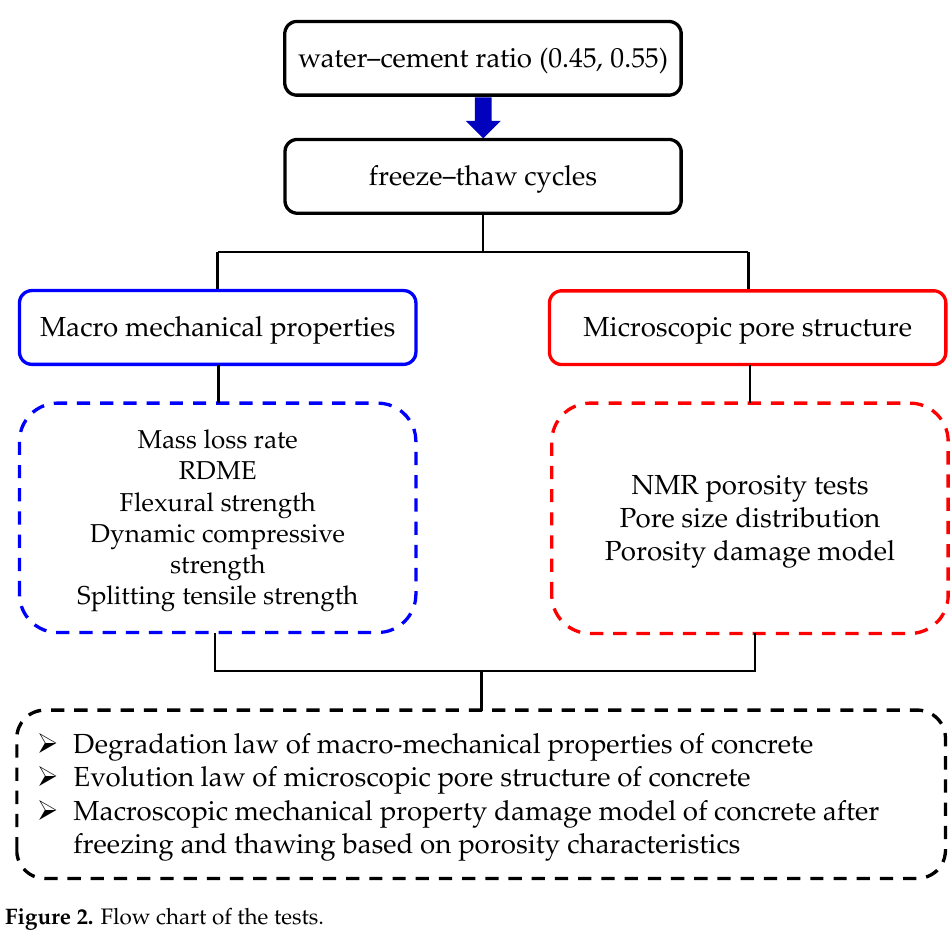
Figure 2. Flow chart of the tests.